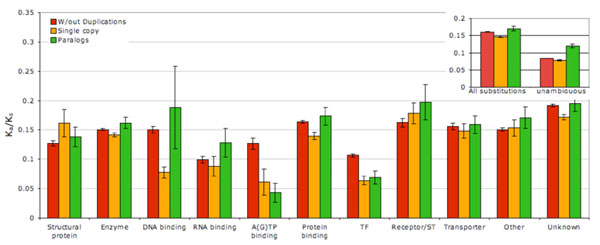
Relative frequency of amino acid substitutions in single copy and duplicated genes. Ka = Number of amino acid substitutions per amino acid site; Ks = cumulative number of synonymous substitutions per 4-fold degenerative site [4], i.e. cumulative length of branches leading to either single copy or duplicated genes. Ka / Ks for single copy and duplicated branches calculated for each gene family separately and averaged by molecular function without weighing. Standard errors shown reflect variance among gene families. Red bars: single copy genes in gene families without duplications; orange bars: single copy genes in gene families with duplication; green bars – duplicated genes. Inset: All substitutions and unambiguous substitutions for all gene families combined.